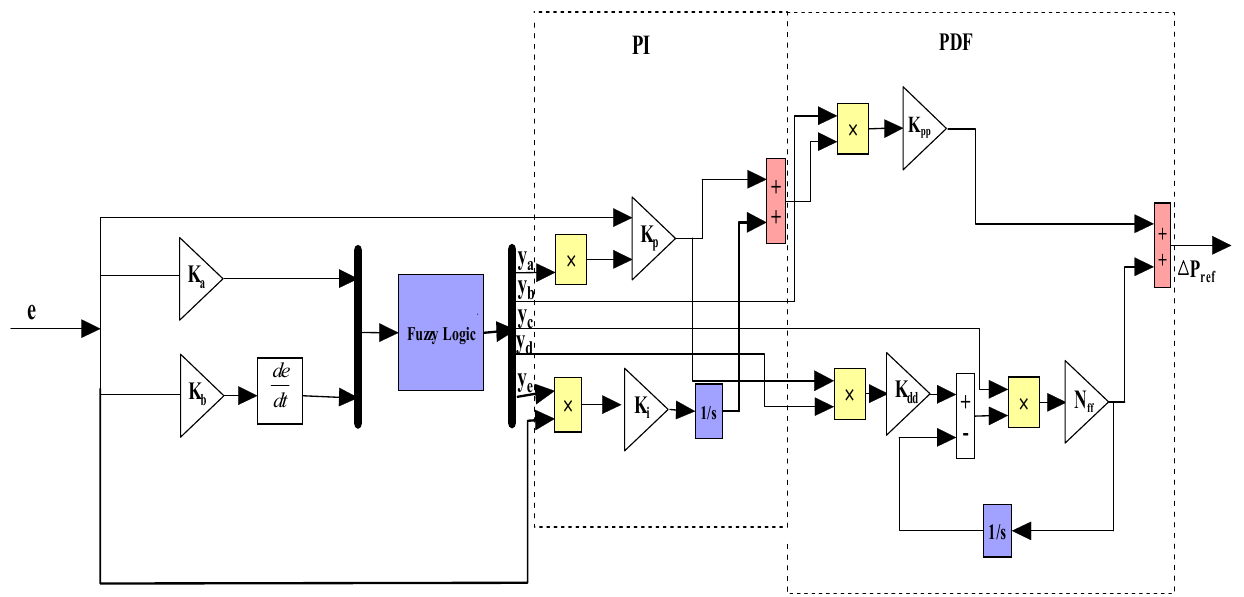
Figure 5. FLC-PI-PDF controller structures.